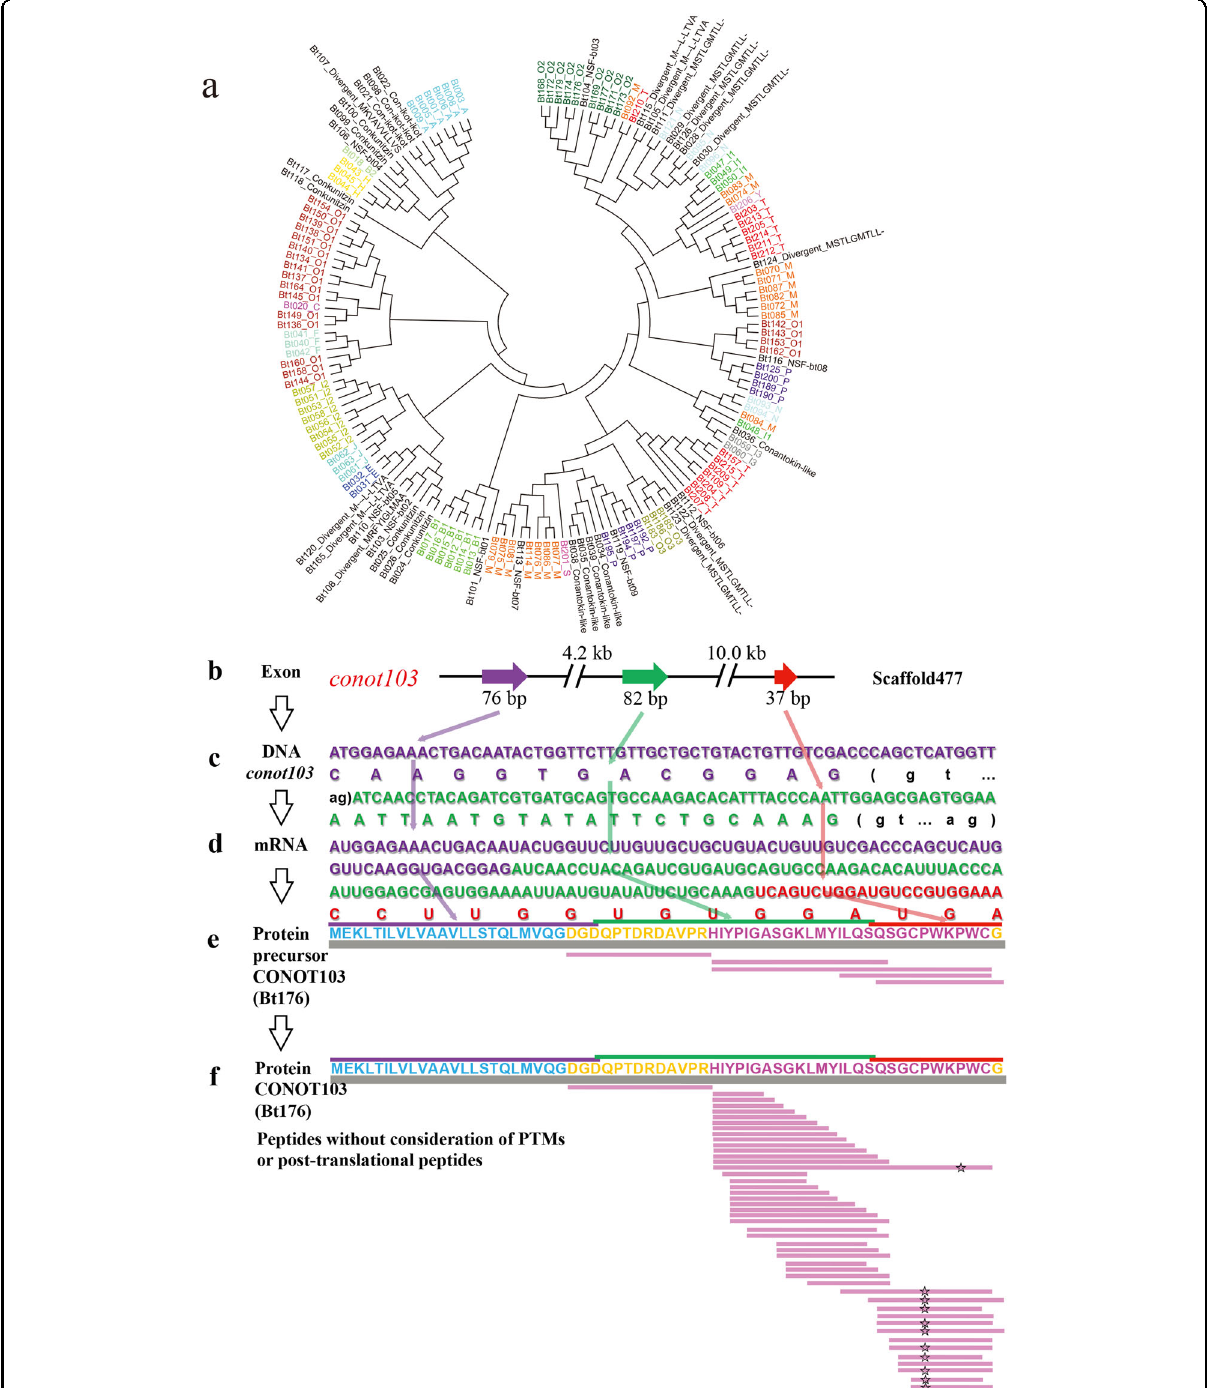
Fig. 3 Identi fi ed conopeptide transcripts and post-transcriptional peptides. a Phylogeny of previously deduced conopeptide precursors with full-length signal peptides 4 . b − e Central dogma of the representative conopeptide CONOT103(Bt176). Regions in purple, green, and red represent the 1st, 2nd, and 3rd exons, or the corresponding sequences, respectively. Sequences highlighted in blue, orange, and red are signal peptides, pro-/ post-peptides, and mature peptides of the precursor, respectively. f Functional conopeptides with post-translational modi fi cations and/or N- and C- terminal truncations 7 that were detected by MS. Amino acid sequences with open star illustrate amino acid modi fi cations at hydroxy-prolines